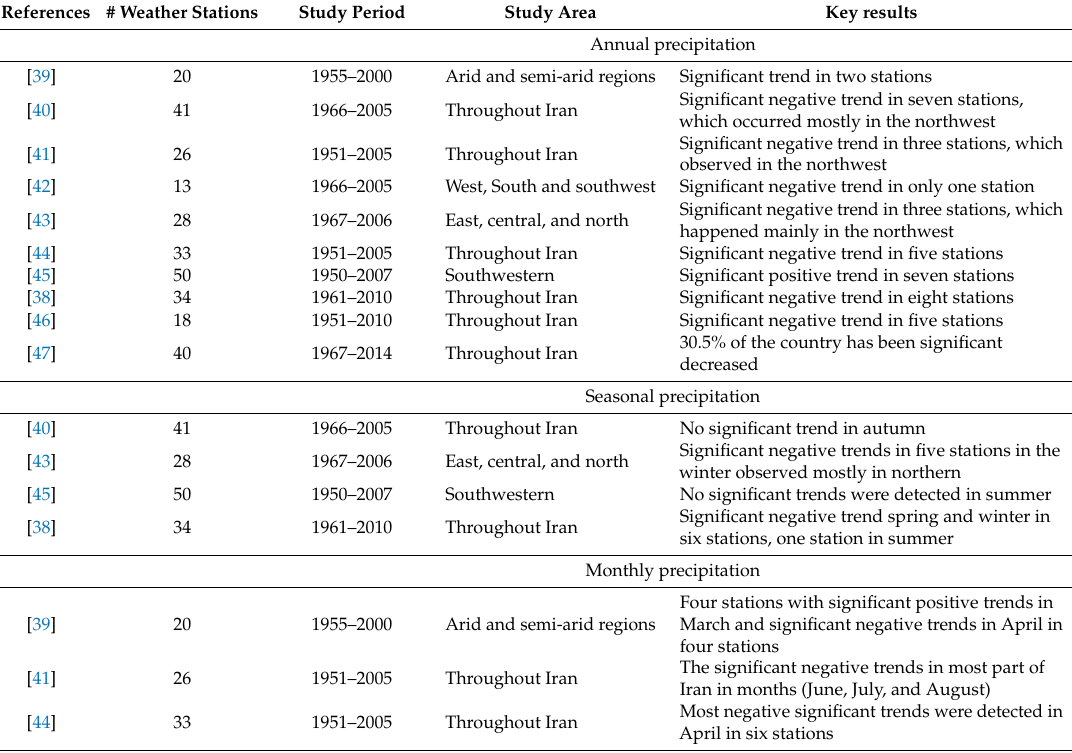
Table 1. Summary of literature review of the precipitation trend analysis in